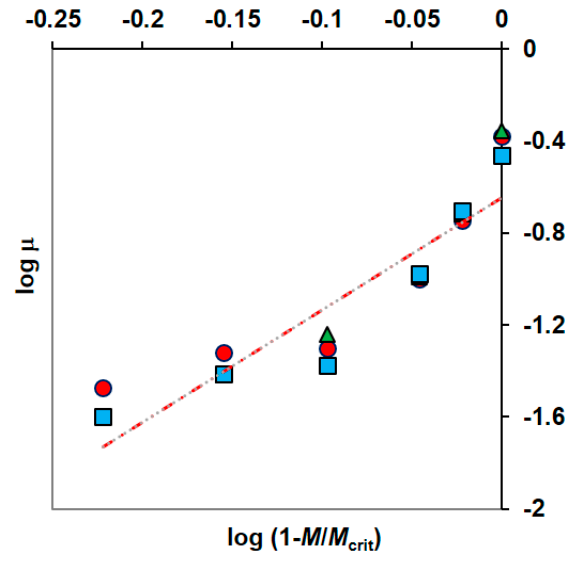
Figure 4. The method of determining the parameters of the Han-Levenspiel model (phenol con- centrations: 100 g·m − 3 ( ● ), 150 g·m − 3 ( ▲ ), 300 g·m − 3 ( ■ )).